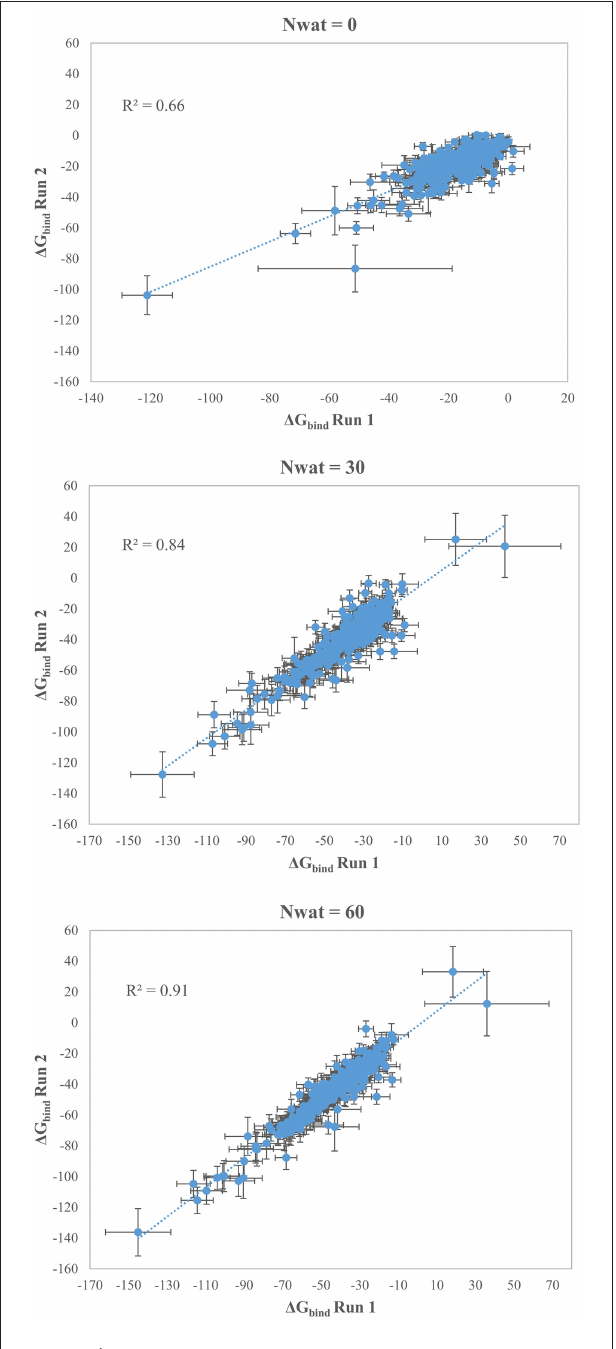
FIGURE 6 | Correlations between the binding energies computed in two independent repetitions (Run 1 and Run 2) for AmpC β -lactamase by standard MM-GBSA (Nwat = 0) or by Nwat-MMGBSA with Nwat = 30 or Nwat =